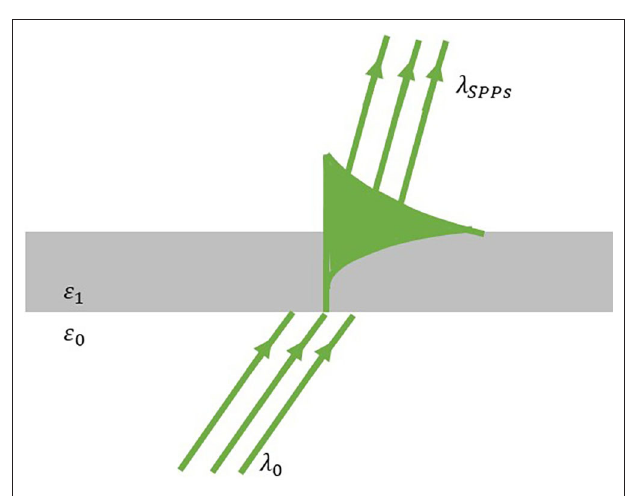
FIGURE 2 | Schematic for surface plasmon polaritons (SPPs) at the metal–dielectric